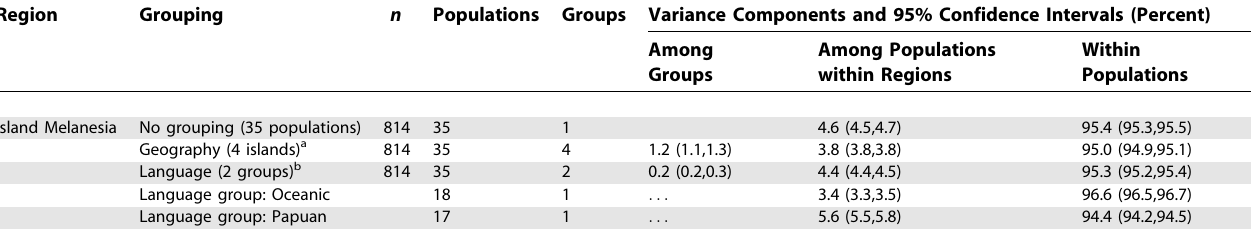
Table 2. Analysis of Molecular Variance (AMOVA) for 687 Microsatellites for Island Melanesia (partitioned by Island and by Language Group) Region